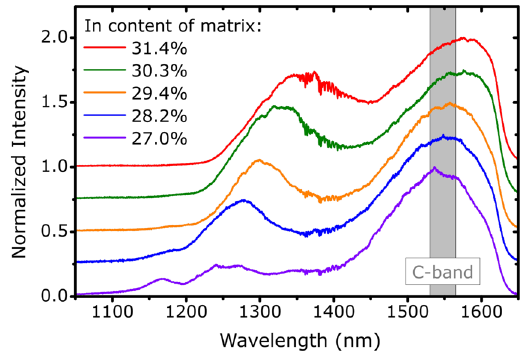
Figure 4: Optimization of growth stage III: Photoluminescence spectra of samples with varying indium content in the In matrix around the QDs. The curves are offset vertically for